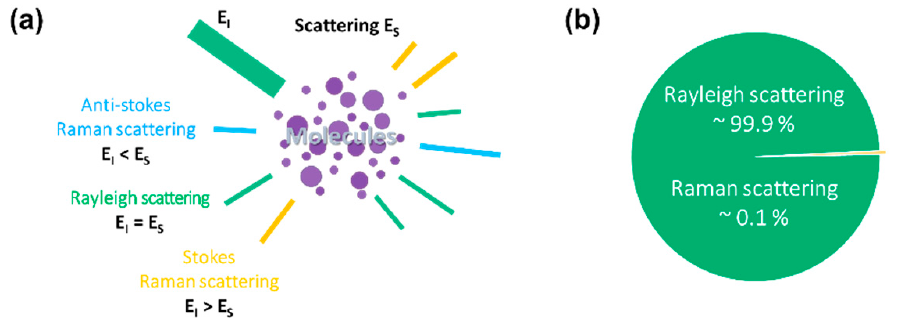
Figure 1. Schematic of Raman scattering. ( a ) Raman scattering is classified into Stokes and anti- Stokes Raman scattering based on the vibrational energy changes. Relative to the incident energy, vibrational energy of the scattered light is lower in the case of Stokes Raman scattering, higher in the case of anti-Stokes Raman scattering, and constant for Rayleigh scattering. ( b ) The scattering of photons by irradiated molecules is predominantly elastic (Rayleigh scattering), accounting for approximately 99.9% of the scattered light. The remaining 0.1% of the scattering is attributed to an inelastic Raman scattering. The atoms of a material are polarized when irradiated by light. This induces an electric dipole since exposure to an electromagnetic field displaces negatively charged subatomic particles from the atomic nuclei. The electric dipole moment induced from irradiation is directly proportional to the strength of the electromagnetic field, where the constant of proportionality denotes the polarizability [12]. Molecular polarizability is the